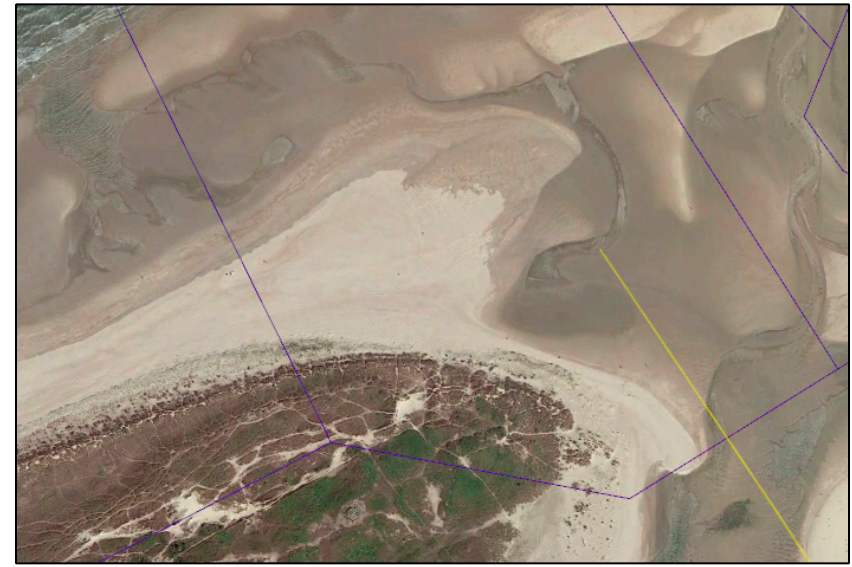
Figure 20. Tidal channel ‘the Zwingeul’ (sections 254 and 255).